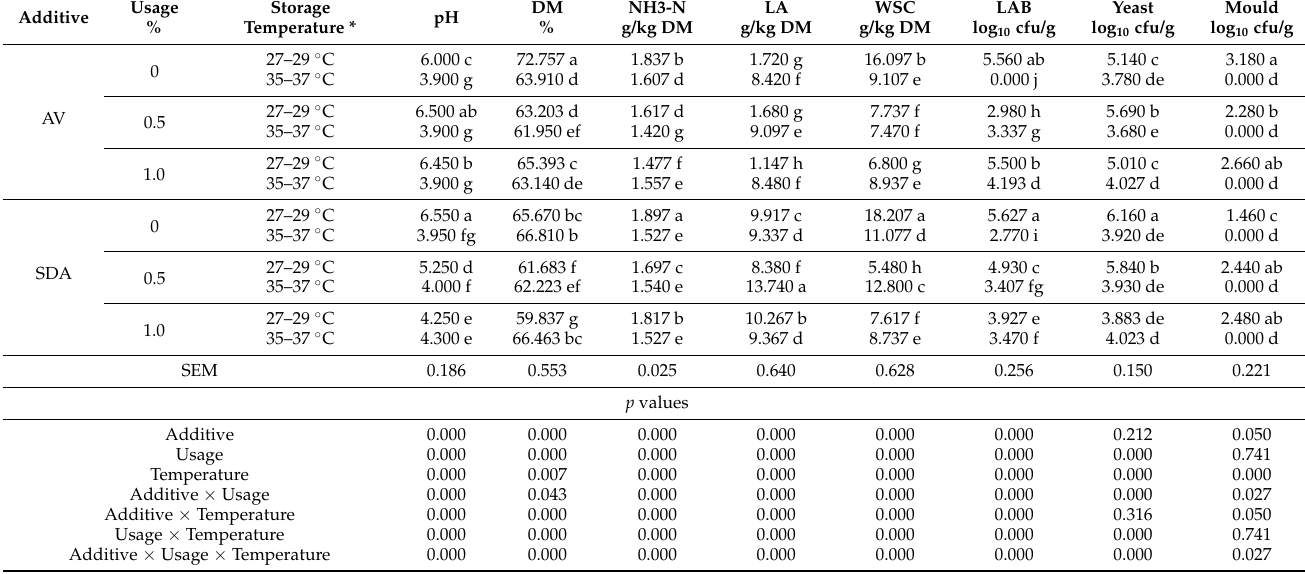
Table 4. Effects of additives and storage conditions on the seventh day of aerobic stability of high moisture maize